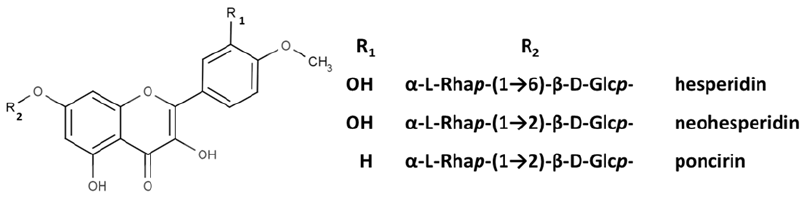
Figure 14. Chemical structures of hesperidin, neohesperidin, and poncirin.